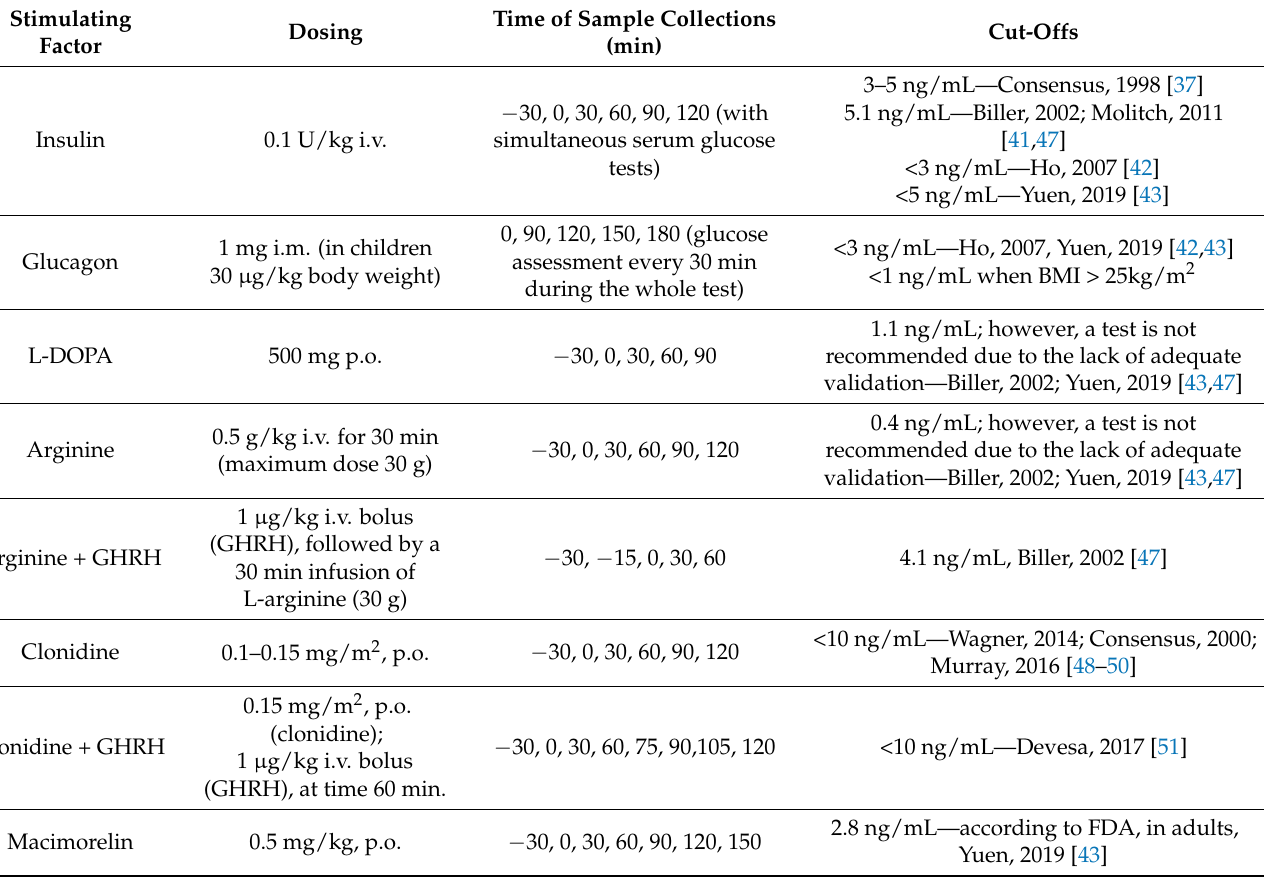
Table 2. The most commonly used tests stimulating GH secretion: methods of testing, dosing and cut-offs.